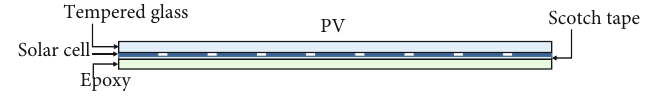
Figure 4: Layout of the tempered glass-based PV panel.